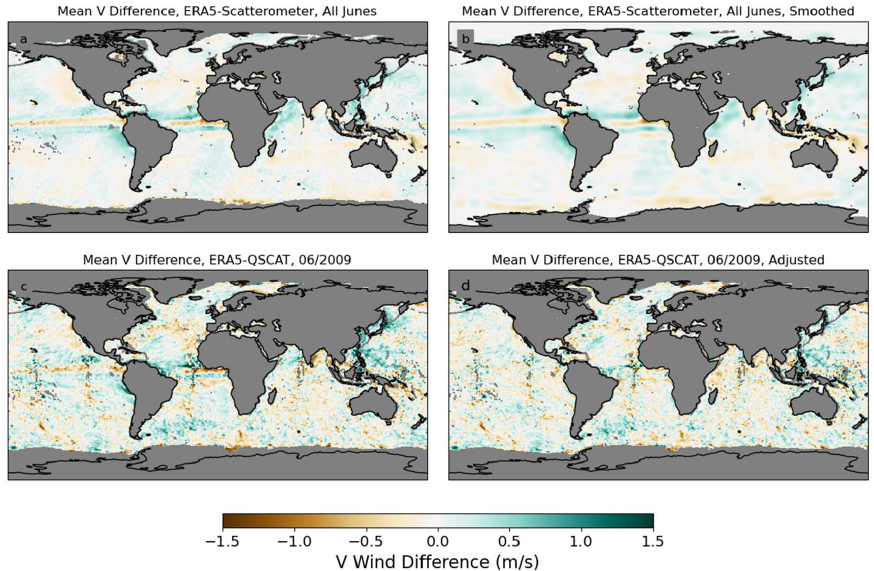
Figure 5. Example of the construction procedure for removing vector component biases. ( a ) Monthly averaged meridional wind difference for June, averaged over QuikSCAT (2000–2009) and ASCAT-A (2007–2019). ( b ) A smoothed version of the differences in ( a ), obtained by fitting the data in ( a ) to a series of spherical harmonics Y lm , with l extending up to 40 and m to +/− 40. ( c ) Differences for (ERA5-QuikSCAT) meridional wind component, before adjustments are applied for June 2009. ( d ) Same as ( c ), except after the adjustment shown in ( b ) is subtracted. The adjustment removes much of the regional biases, particularly near the Equator.